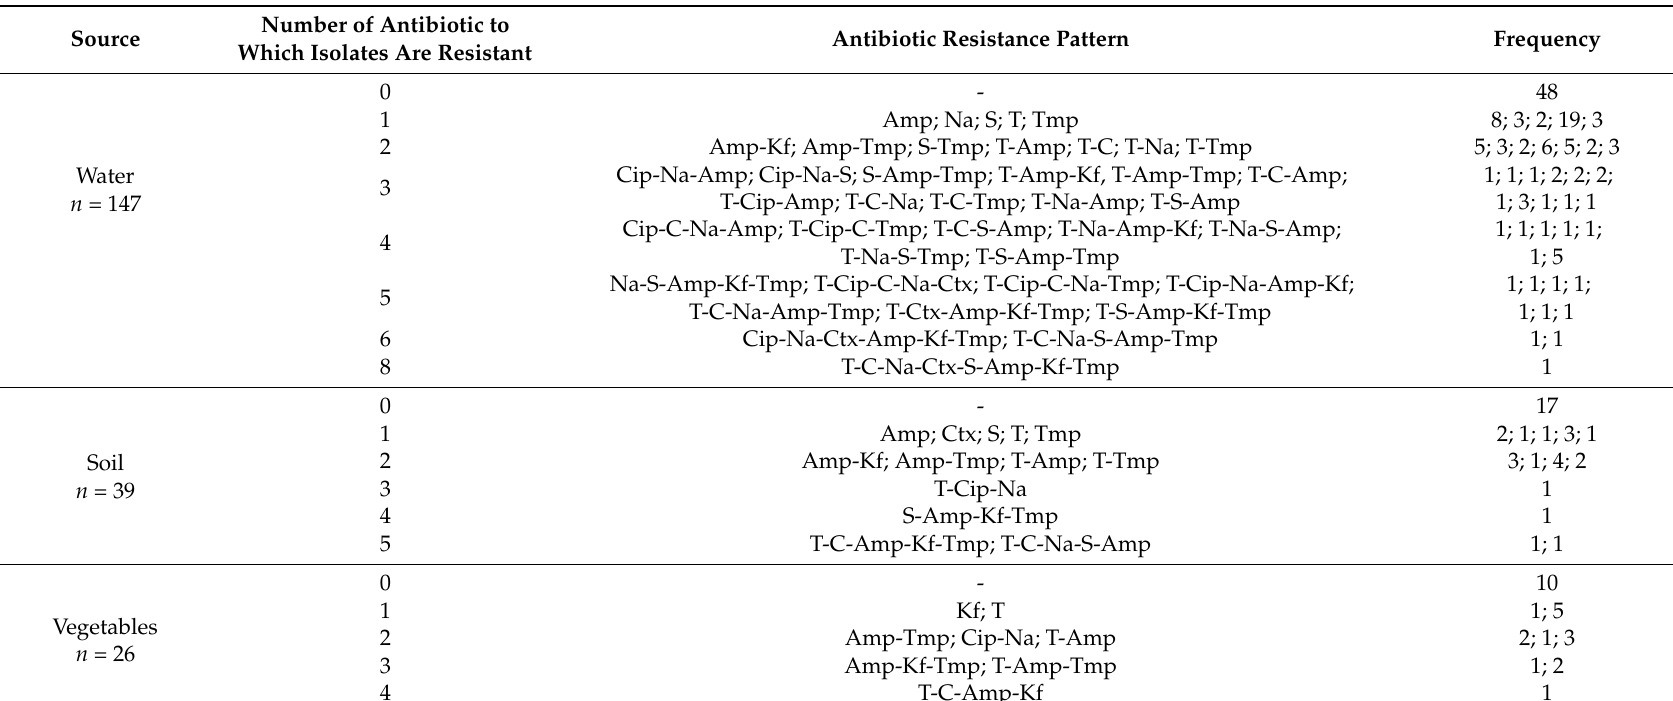
Table 3. Antibiotic resistance pattern among E. coli isolates from agricultural irrigation water in Metro Manila,